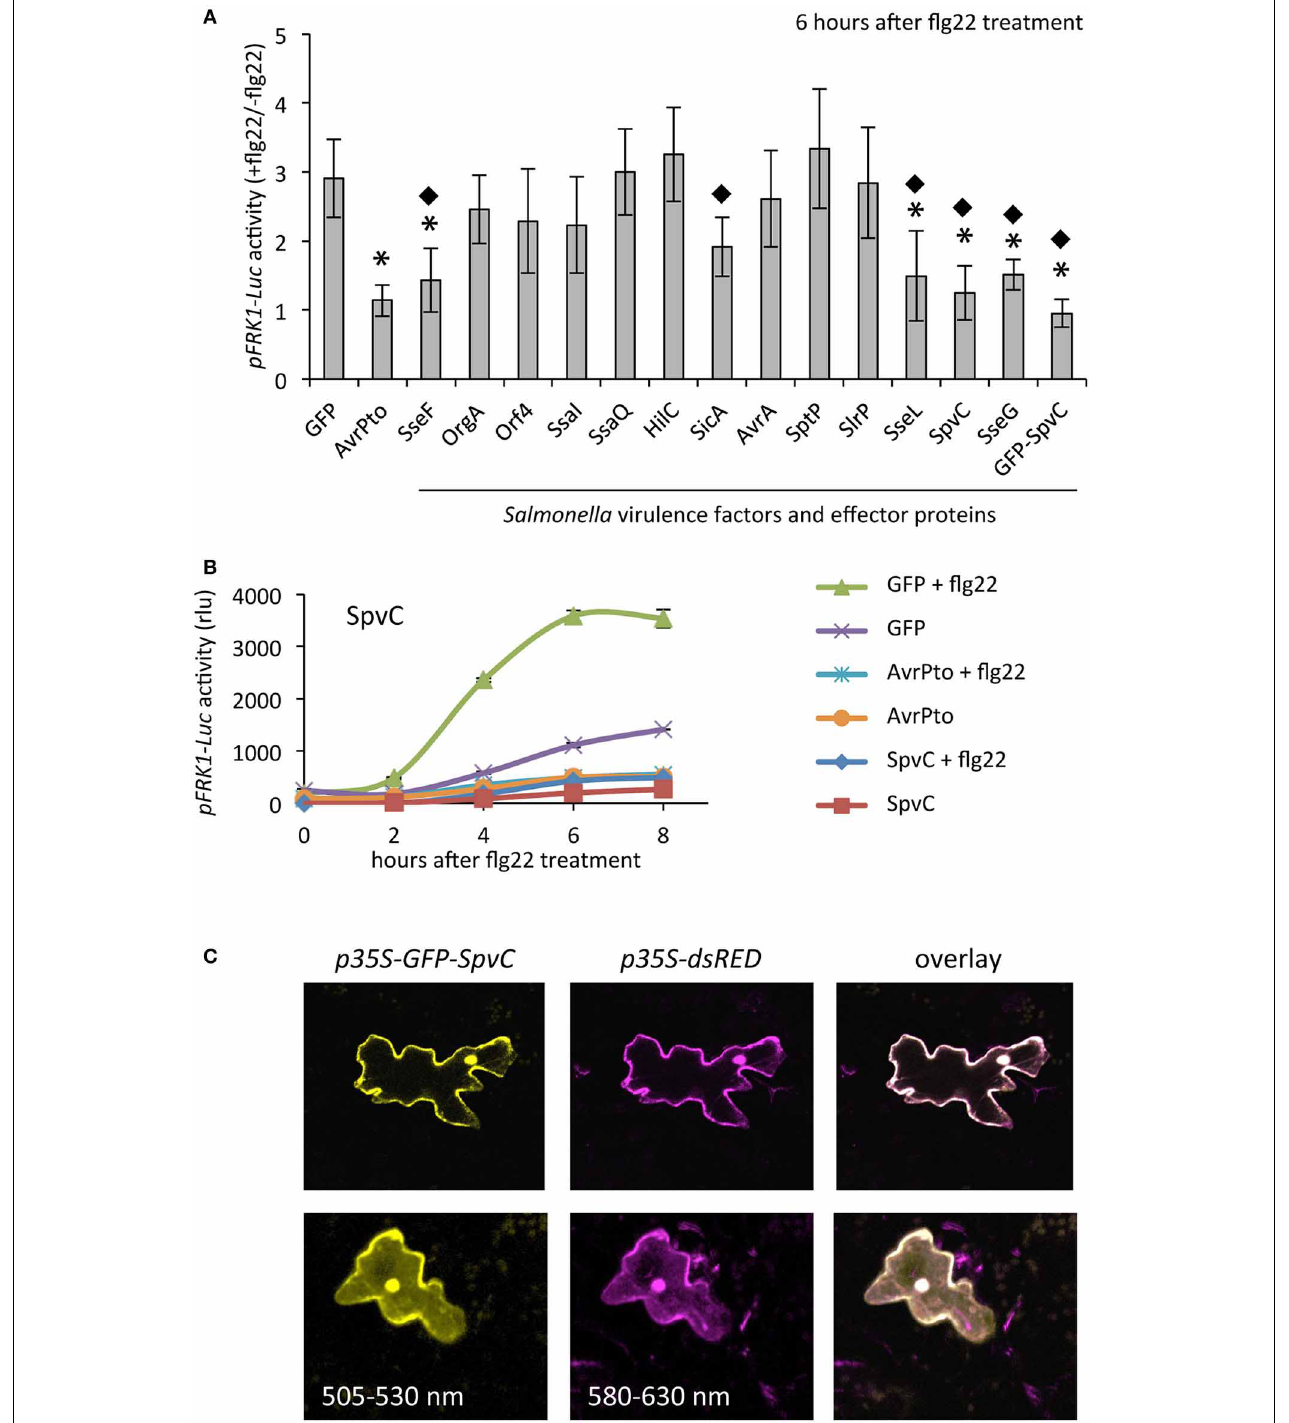
FIGURE 2 | Suppression of flg22-induced pFRK1-Luc expression by Salmonella proteins. (A) Mesophyll protoplasts from Arabidopsis thaliana Col-0 were co-transformed with pFRK1-Luc and p35S-Salmonella-ORF plasmids. Co-transformations of pFRK1-Luc with p2FGW7 (GFP) and with p2GW7-AvrPto (AvrPto) plasmids served as controls. Protoplasts were subsequently treated with flg22 or left untreated. The ability to suppress the flg22-driven activation of pFRK1-Luc of chosen virulence factors and effectors